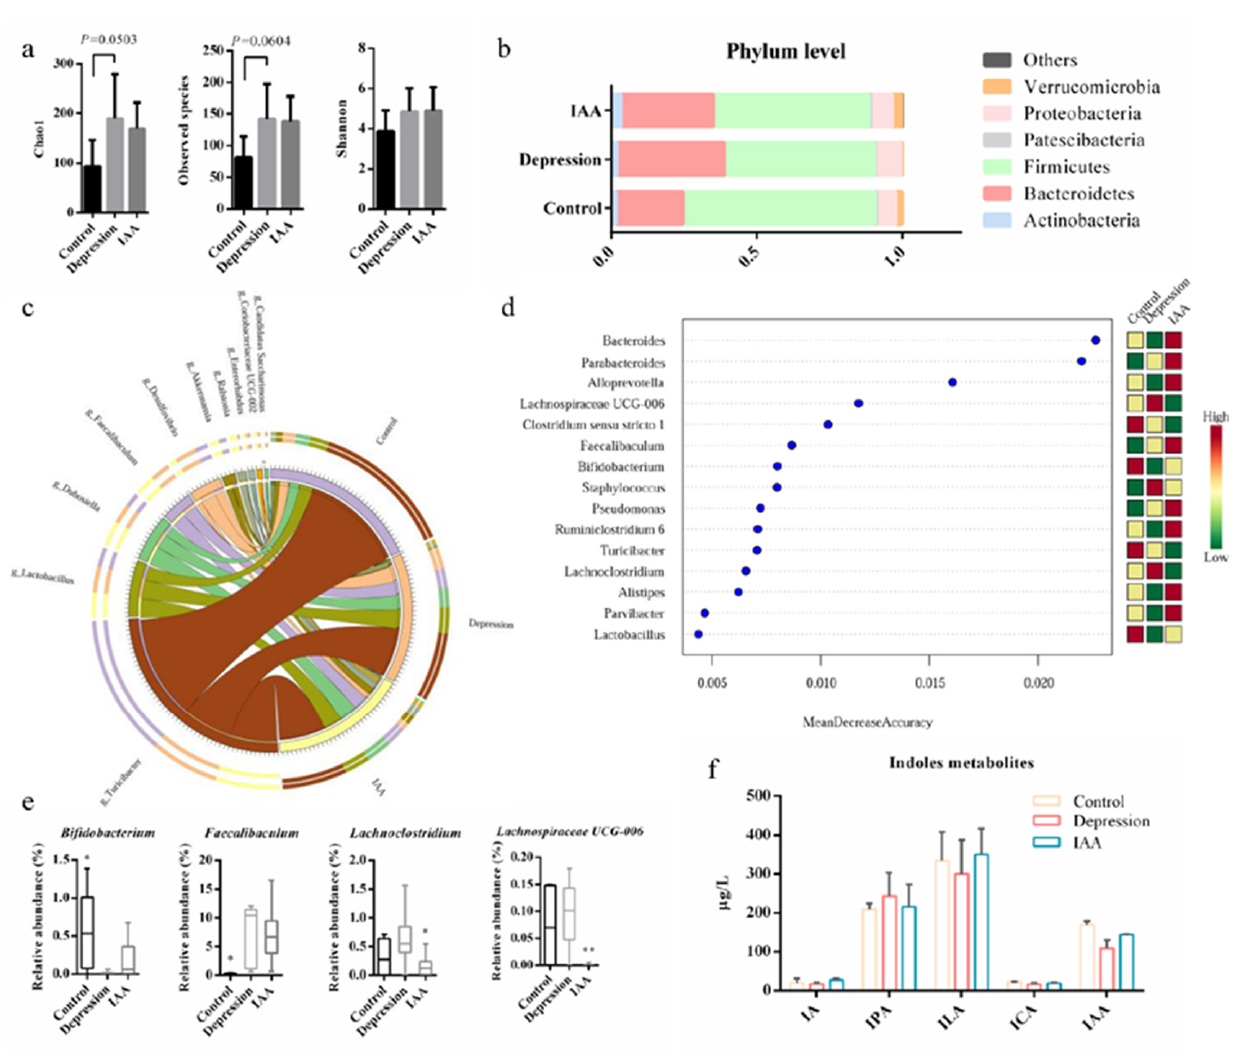
Figure 4. Analysis of the gut microbiota in the content of the small intestine. ( a ) Alpha diversity indicated by Chao1, Observed species and Shannon index. ( b , c ) Relative abundance of main bacterial communities at the phylum level and the genus level (main genera > 1%). ( d ) Differential analysis of bacterial genera in the three groups. ( e ) Relative abundance of selected differential genera. ( f ) Concentrations of indole derivatives metabolized from tryptophan in the serum. Compared with the depression group, * p < 0.05, ** p < 0.01, data are means and SD, one-way ANOVA followed by Tukey’s post-test.